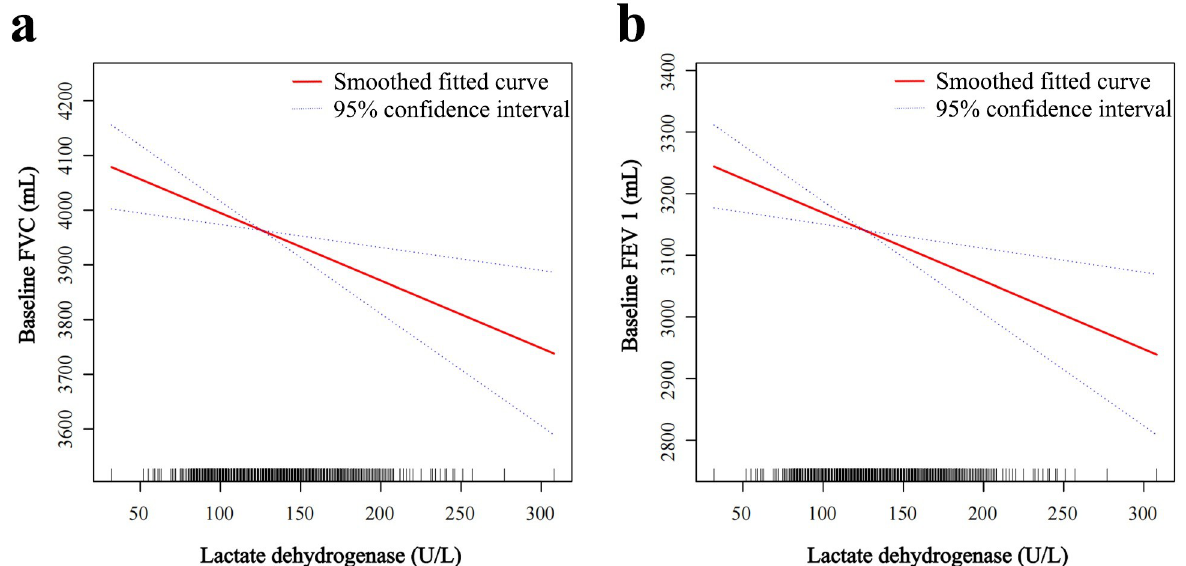
Fig 2. Association between serum lactate dehydrogenase and pulmonary function indicators FVC and FEV1. The red line represents the smoothed curve fit between the variables. (a) Solid line plots of curve fits for baseline lactate dehydrogenase and FVC for the main variables. (b) Solid line plots of curve fits for the primary variable between baseline lactate dehydrogenase and FEV 1. The blue line represents the 95% confidence interval of the fit. Full sample mobile examination center exam weight. Adjusted for age (smooth), sex, education, race, surgery (yes, no), respiratory disease (yes, no), cigarettes (yes, no), weight (smooth), standing height (smooth), diastolic blood pressure (smooth), systolic blood pressure (smooth), glucose, serum (smooth), cholesterol (smooth), creatinine (smooth), alanine aminotransferase (smooth), albumin (smooth), globulin (smooth).